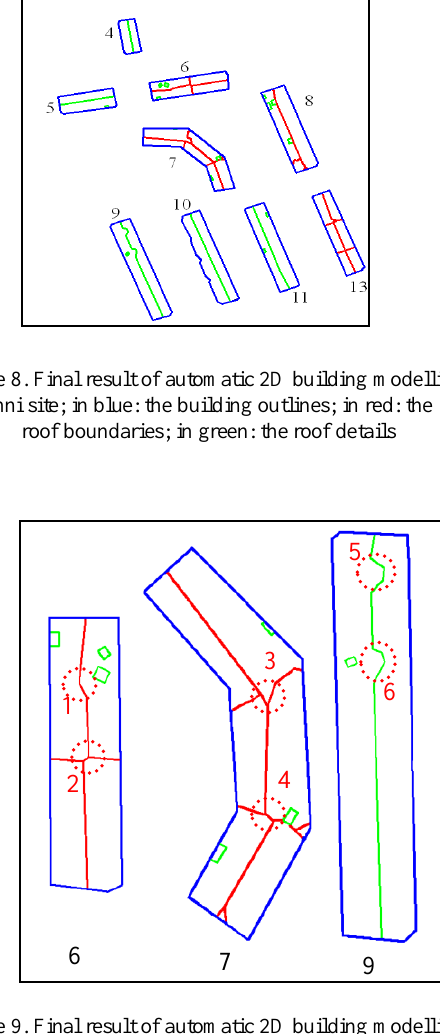
Figure 9. Final result of automatic 2D building modelling; Three selected buildings (Buildings 6, 7 and 9); in blue: building outlines; in red: inner roof boundaries; in green: roof